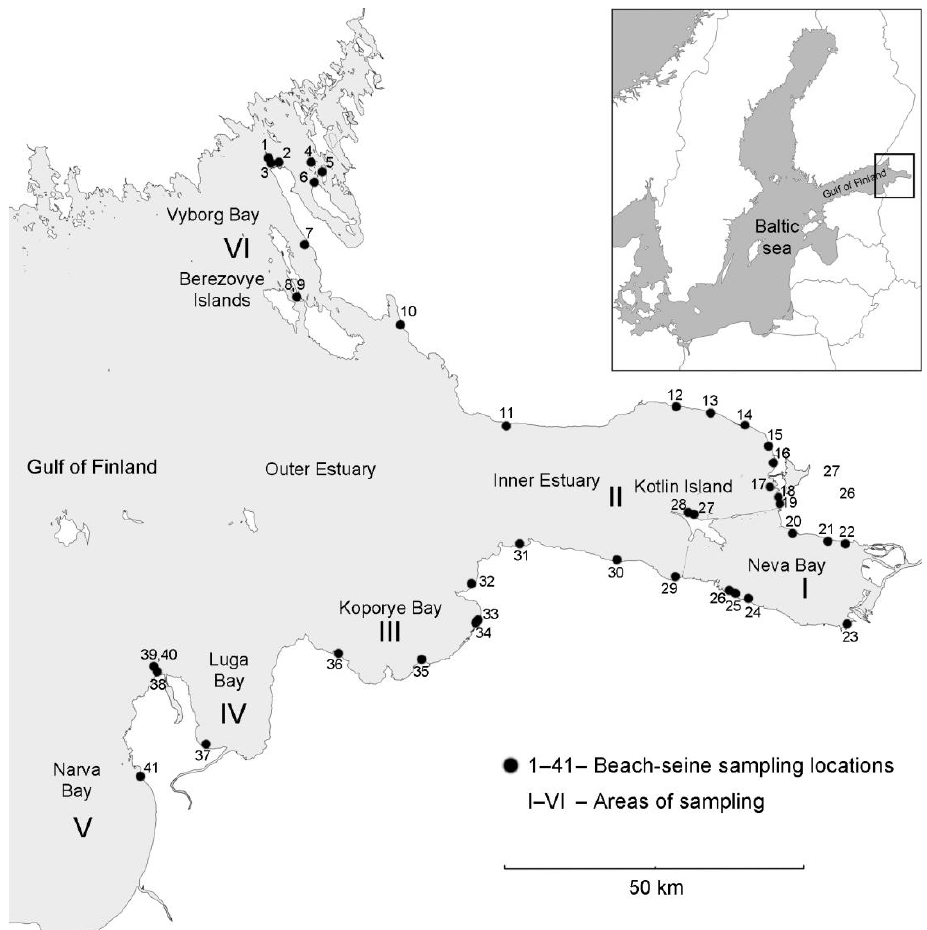
Figure 1. Study area and sampling locations in the eastern Gulf of Finland (2011 – 2017). The sampling was performed during ice-free season from May to November. All samples were sorted to spring (till June 15), summer (from 15 June to the 15 September), and autumn (from 15 September) periods. Sampling periods were not equal to calendar seasons due to sampling often occurring in alternating months. For example, samples made in late August and early September in the same temperature and weather conditions were combined.